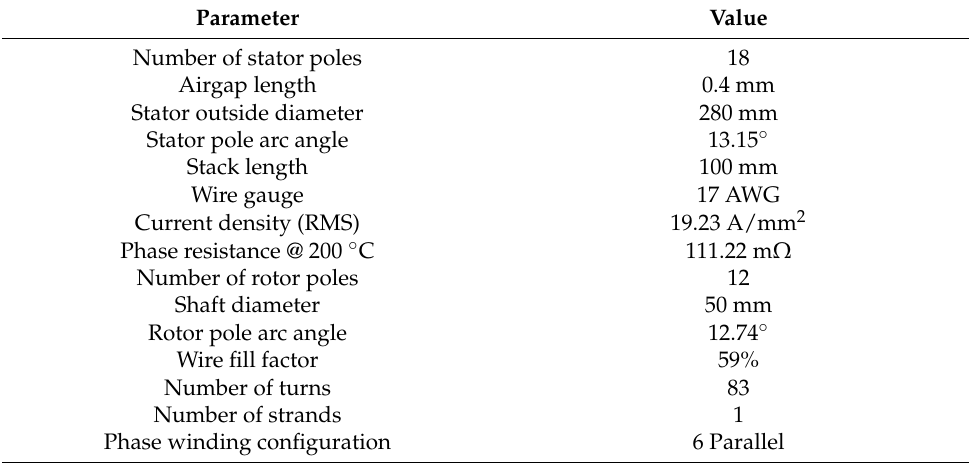
Table 5. 18/12 SRM Final Geometry and Coil Configuration.